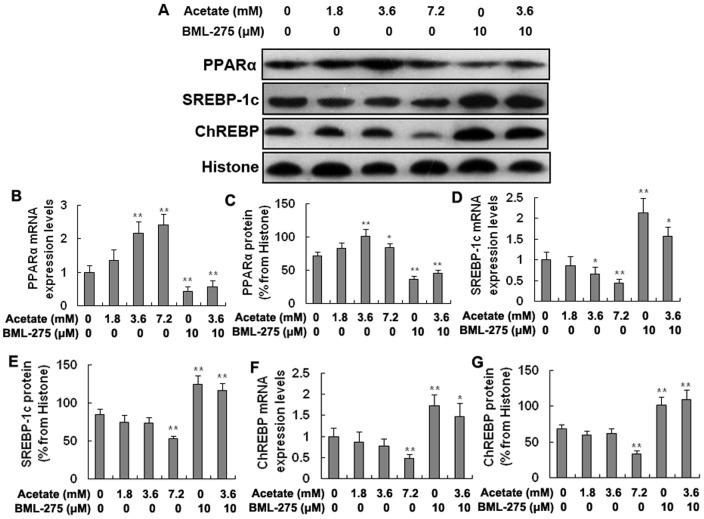
The mRNA and protein expression levels of PPARα, SREBP-1c, and ChREBP in the hepatocytes.Hepatocytes were treated with acetate and BML-275 and divided into a control group (0 mM acetate), a low-dose acetate treatment group (1.8 mM acetate), a medium-dose acetate treatment group (3.6 mM acetate), a high-dose acetate treatment group (7.2 mM acetate), a BML-275 group (10 μM BML-275), and a BML-275+acetate group (10 μM BML-275+3.6 mM acetate). Acetate (sodium acetate) was used in the form of neutralized acetic acid to avoid changing the pH of the medium. A: Western blotting results of PPARα, SREBP-1c, and ChREBP. B and C: mRNA and protein levels of PPARα. D and E: mRNA and protein levels of SREBP-1c. F and G: mRNA and protein levels of ChREBP. * p<0.05, ** p<0.01 versus the control group.